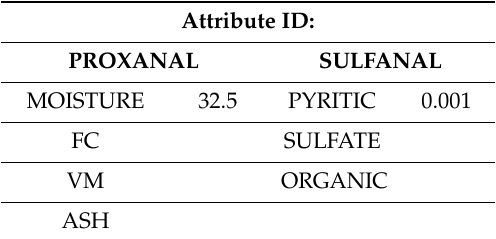
Table A1. Pyrolysis oil nonconventional